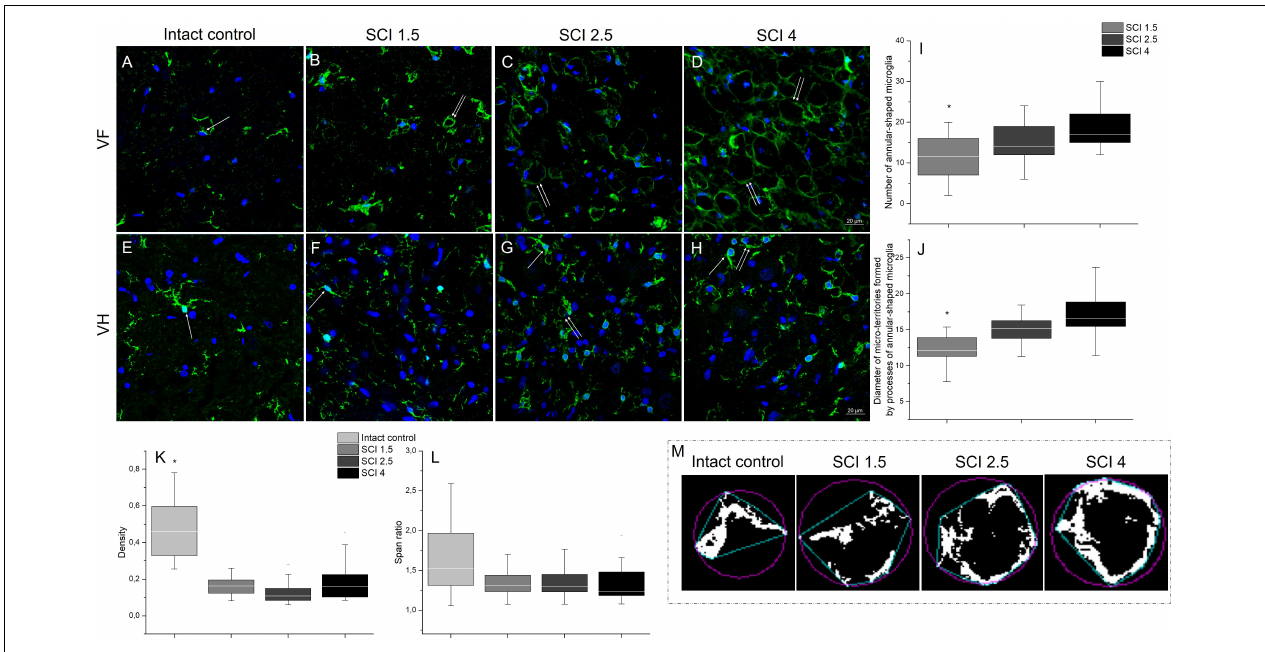
FIGURE 5 | Analysis of microglia morphology in SCI and intact controls. Visualization of microglia morphology using anti-Iba1 antibody (green) within the ventral funiculi (VF) and ventral horn (VH) at 60 days after spinal cord injury of mild (SCI 1.5; B,F) , moderate (SCI 2.5; C,G) , and severe (SCI 4; D,H ) severities and intact controls (A,E) at a distance of 5 mm caudally from the epicenter of injury. All sections were imaged in the z-plane using identical confocal settings (laser intensity, gain, and offset). Annular-shaped microglia indicated by the arrow. Nuclei are DAPI-stained (blue). Scale bar: 20 µ m. Number of annular-shaped microglia (I) and diameter of micro-territories formed by processes of annular-shaped microglia (J) within the VF at 60 days after SCI 1.5 (a light gray column), SCI 2.5 (a gray column), or SCI 4 (a black column). *p < 0.05 as compared with all investigated groups, one-way ANOVA, followed by a Tukey’s post hoc test. Summary data of microglia density (K) and span ratio (L) within the VF at 60 days in abovementioned experimental groups and intact controls. Schematic illustration of the convex hull (blue) and bounding circle (purple) in binary photomicrographs in the investigated groups necessary for calculating the microglia span ratio and density (M) .